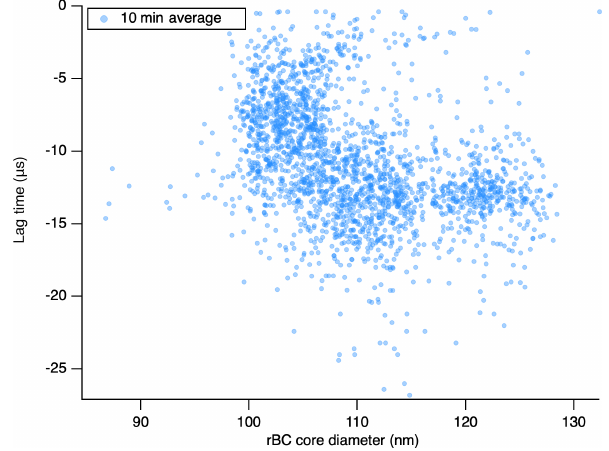
Figure 7. Scatterplot of 10min mean negative lag times versus 10min mean rBC core